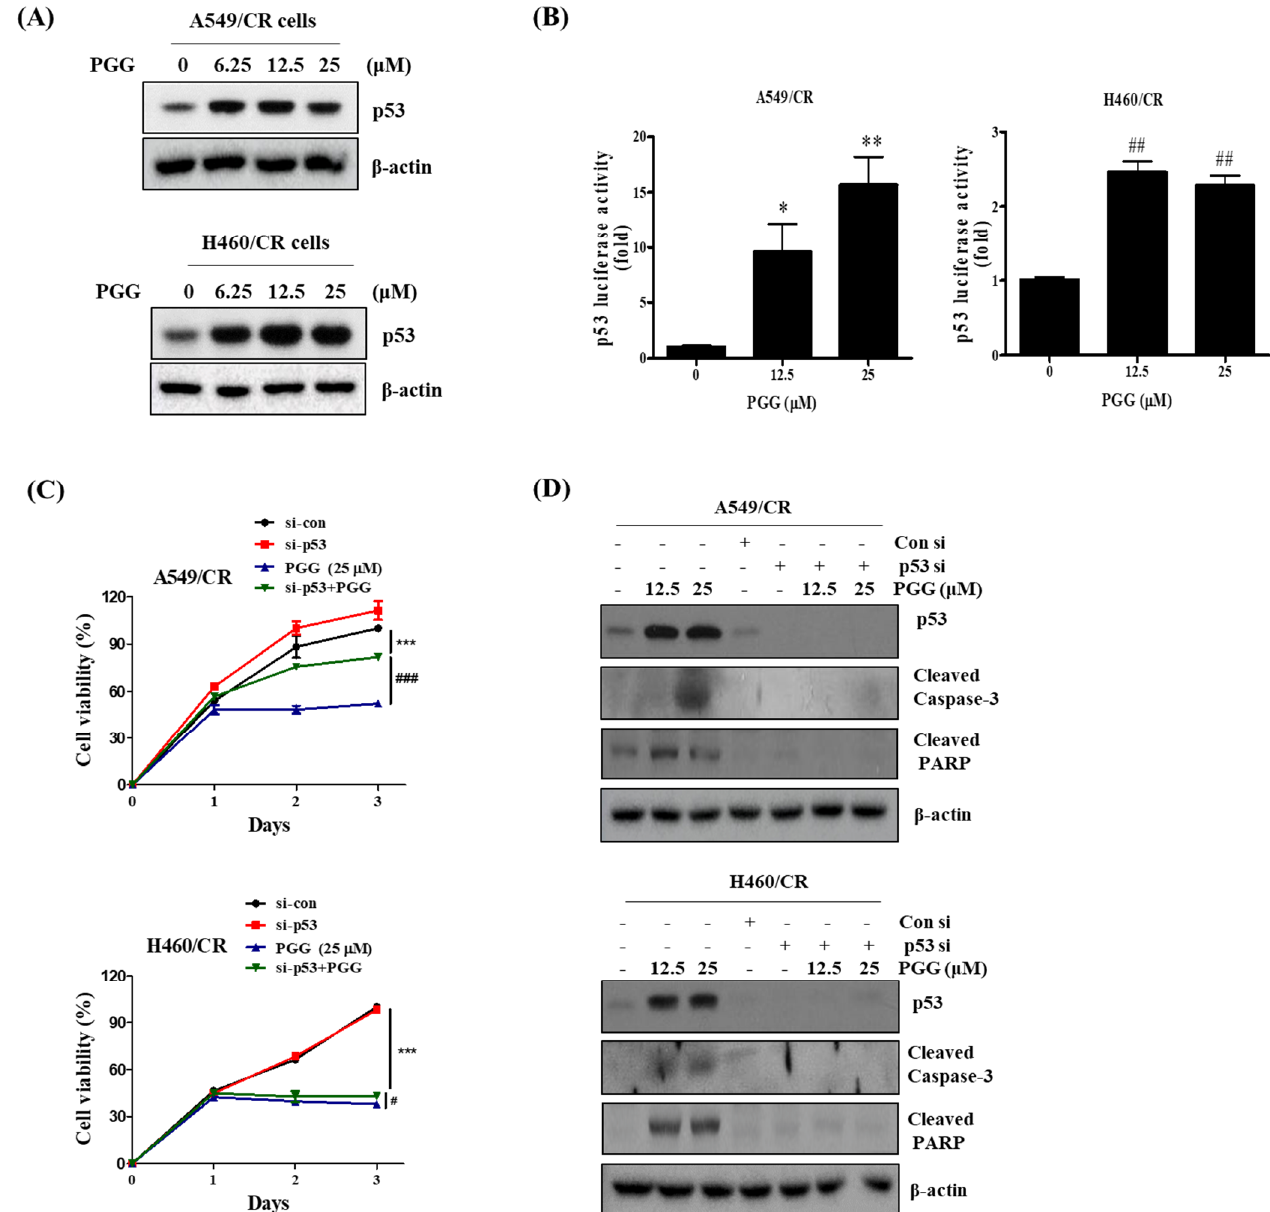
Figure 6. The pivotal role of p53 in PGG-induced apoptosis in A549/CR and H460/CR cells. ( A ) Effect of PGG on the protein expression of p53 in A549/CR and H460/CR cells. *, p < 0.05, **, p < 0.01 vs. untreated control. ##, p < 0.01 vs. untreated control. ( B ) Effect of PGG on p53 luciferase activity in A549/CR and H460/CR cells. ( C ) Effect of p53 depletion on the viability of A549/CR and H460/CR cells. ***, p < 0.001 vs. untreated control. #, p < 0.05, ###, p < 0.001 vs. untreated control. ( D ) Effect of p53 depletion on PARP and cleaved caspase 3 induced by PGG in A549/CR and H460/CR cells. Three independent assays were conducted.